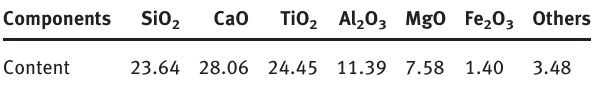
Table 1: Chemical composition of the titanium-bearing blast fur- nace slag (wt%).